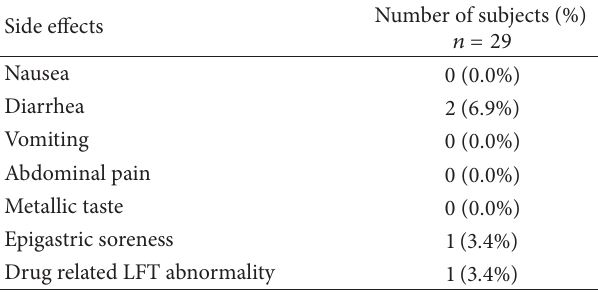
Table 2: Side effects of high dose ilaprazole plus amoxicillin